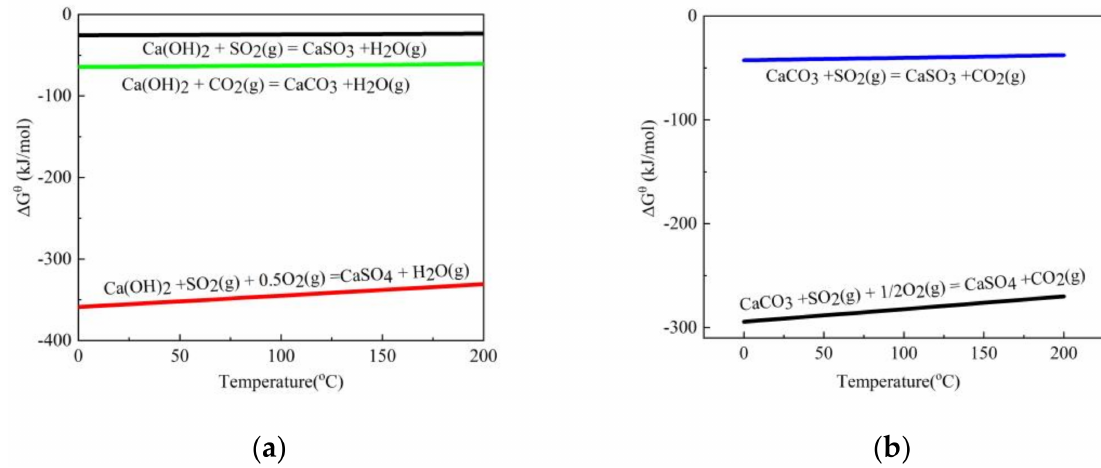
Figure 5. The ∆ G θ -T diagram of chemical reactions of ( a ) Ca(OH) 2 and mixed gas; ( b ) CaCO 3 and mixed